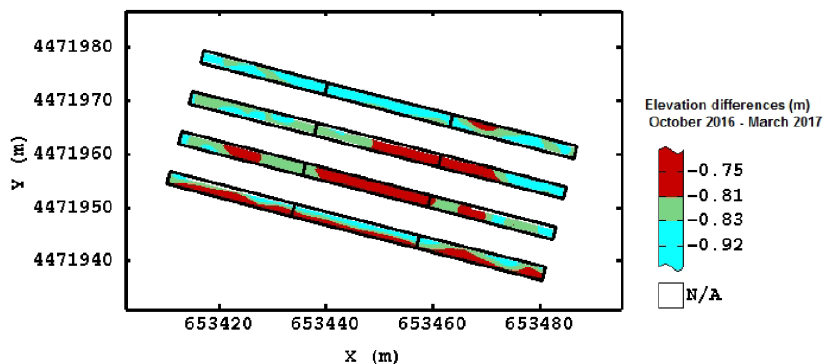
Figure 9. Map of the elevation differences (in meters) between the estimated elevation in October 2016 and in March 2017.